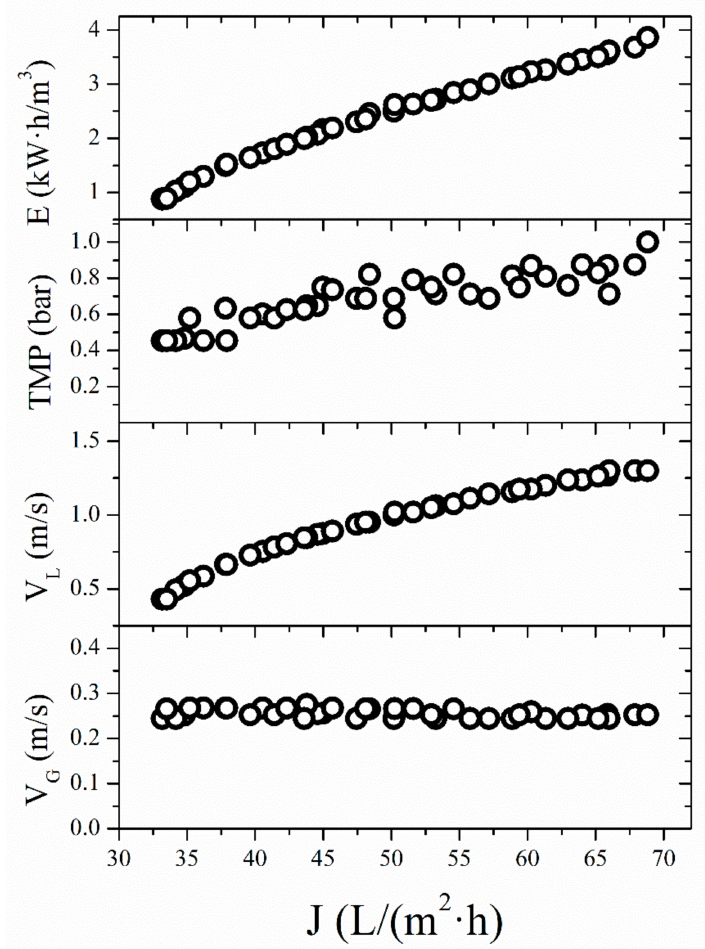
Figure 2. The Pareto front plot and decision space of the optimal solution set obtained from the multi- objective genetic algorithm optimization during microfiltration of Bacillus velezensis IP22 cultivation broth aided with air